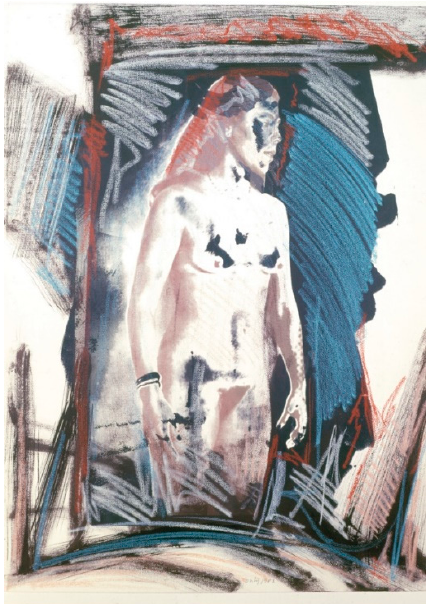
Figure 14. Josely Carvalho, Female Tales of Purgatory , 1983, silkscreen and crayon on paper, 30 × 22.5 inches. Courtesy of the artist. Image credit: Sarah Welss, used by permission.